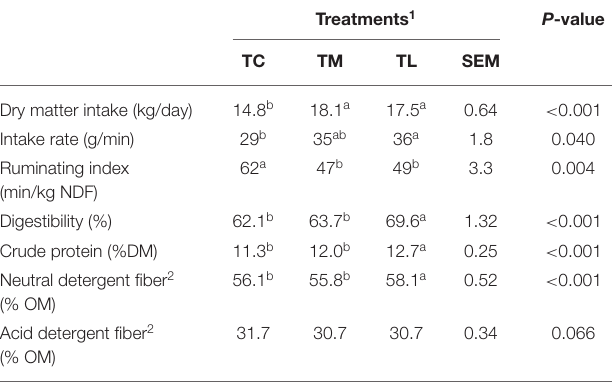
TABLE 5 | Effect of post-grazing sward height on dry matter intake, ingestive process, and nutritional characteristics of selected diet by lactating cows. Treatments 1 P